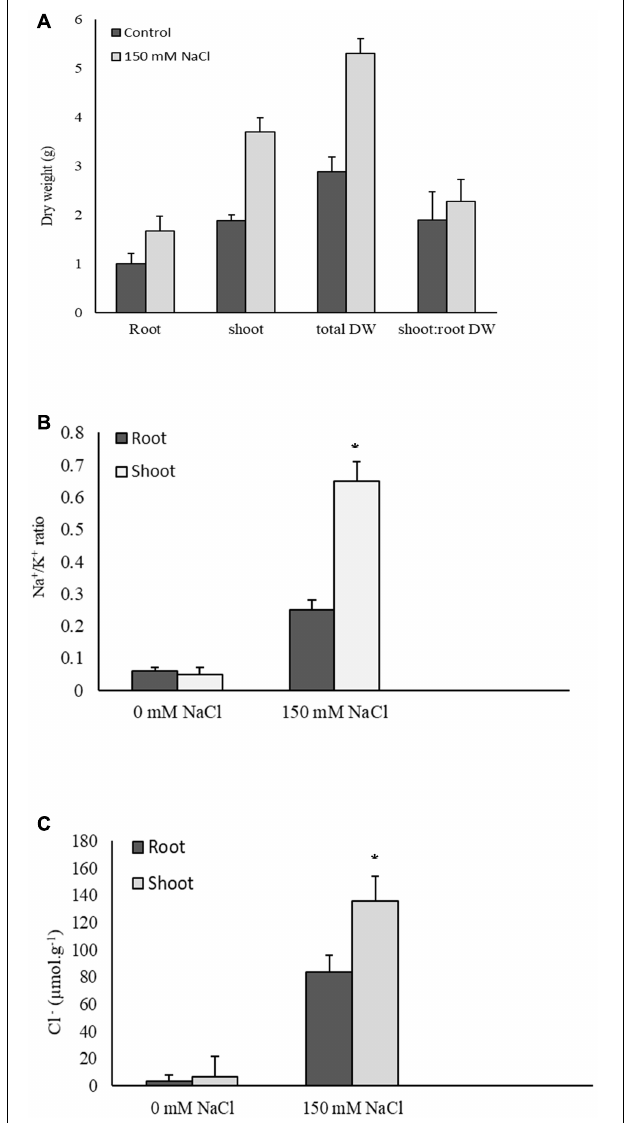
FIGURE 1 | Root, shoot, and total dry weights and shoot: root dry weight ratios in Puccinellia nuttalliana treated with 0 mM and 150 mM NaCl for 6 days. Means ( n = 6) ± SE are shown (A) , Na + /K + ratios (B) , and Cl - concentrations (C) in roots and shoots of Puccinellia nuttalliana treated with 0 mM and 150 mM NaCl for 6 days in hydroponic system. Asterisks above the bars indicate significant differences ( p ≤ 0.05) between treatments as determined by the Tukey’s test. Means ( n = 6) + SE are